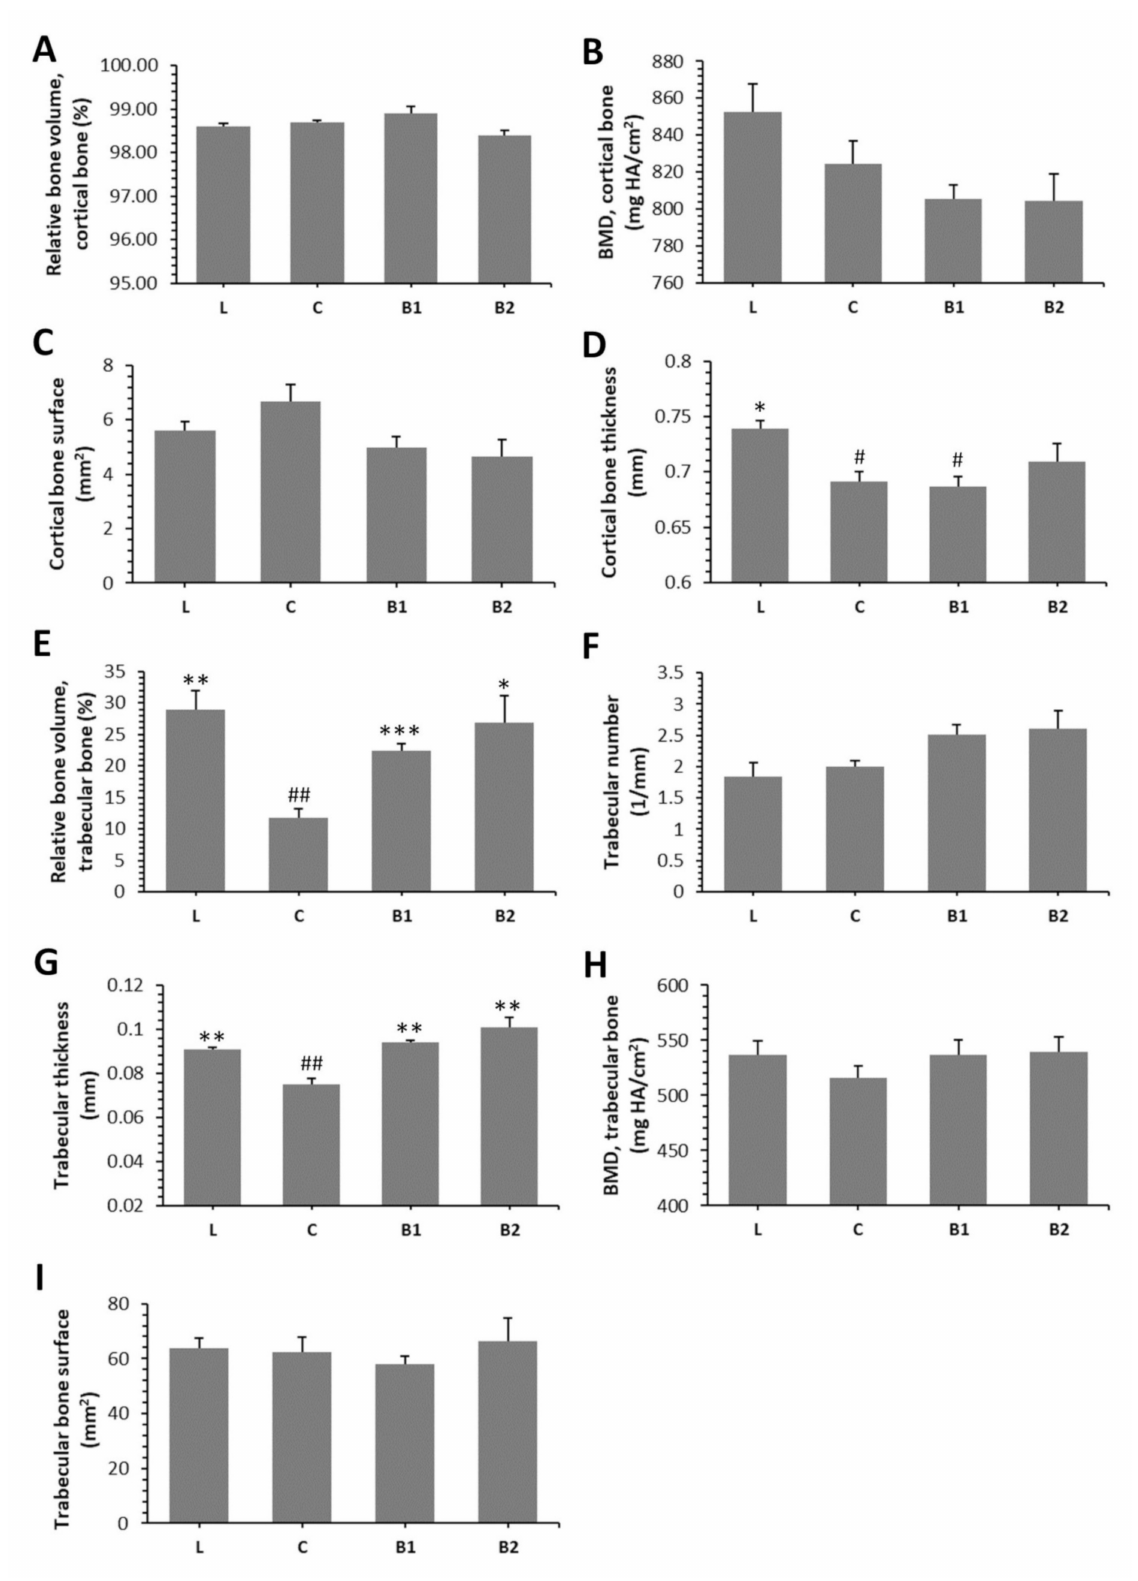
Figure 3. Effects of BB on morphological 3D parameters of the cortical bone ( A – D ) and trabecular bone ( E – I ) in ZDF rats. BMD—bone mineral density. * Significant differences compared with the C group ( p < 0.05), ** significant differences compared with the C group ( p < 0.01), *** significant differences compared with the C group ( p < 0.001), # significant changes in relation to the L group ( p < 0.05), and ## significant changes in relation to L group ( p <